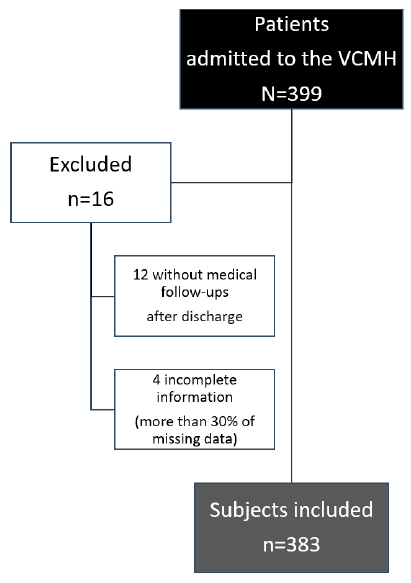
Figure 1. Flowchart of the patients included in the study.